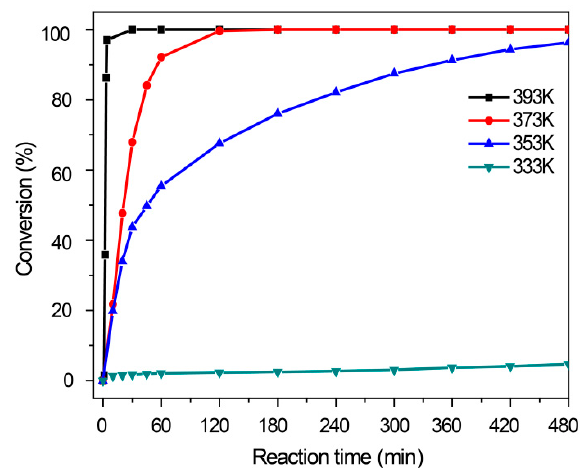
Catalysts 2019 , 9 , x FOR PEER REVIEW Figure 9. Conversion of benzyl alcohol in benzlyation of mesitylene. Figure 9. Conversion of benzyl alcohol in benzlyation of mesitylene.